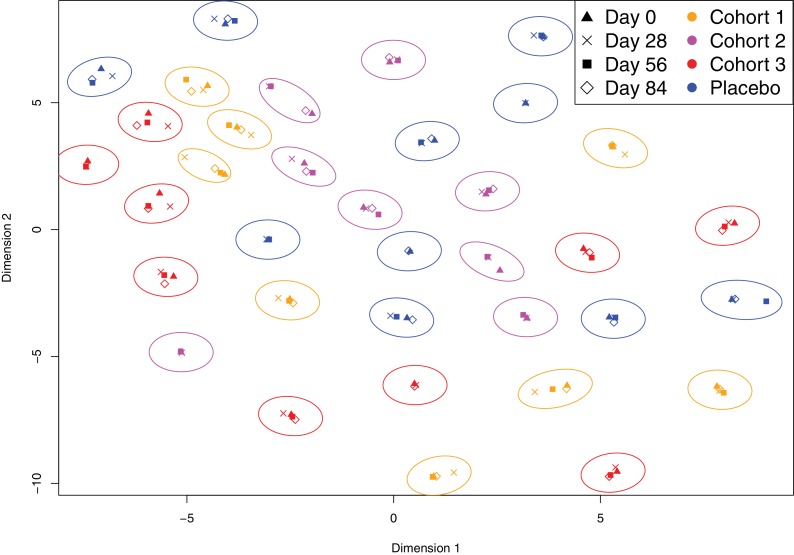
Evidence of distinct antibody fingerprints of trial participants from non-DCL probes.The t-SNE analysis shown in Figure 2 was repeated, excluding the probes corresponding to the DCL. Longitudinal samples from the same individual again cluster together, demonstrating the distinctiveness of individuals’ antibody repertoires was apparent even when the allelic variation of PspA, PspC, ZmpA and ZmpB were excluded. The longer-range structure of the projection is stochastic, and these differences with Figure 2 are not biologically relevant.